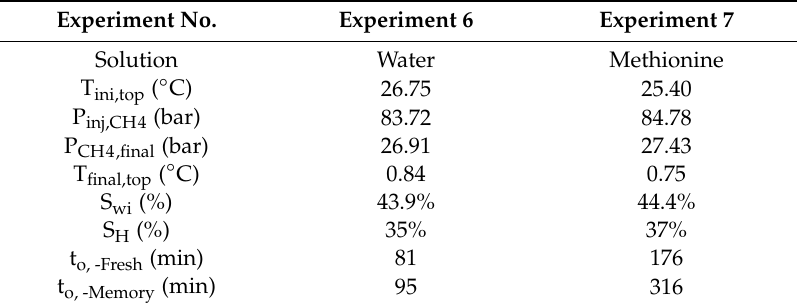
Table 4. Methane hydrate formation in the presence of water and methionine.